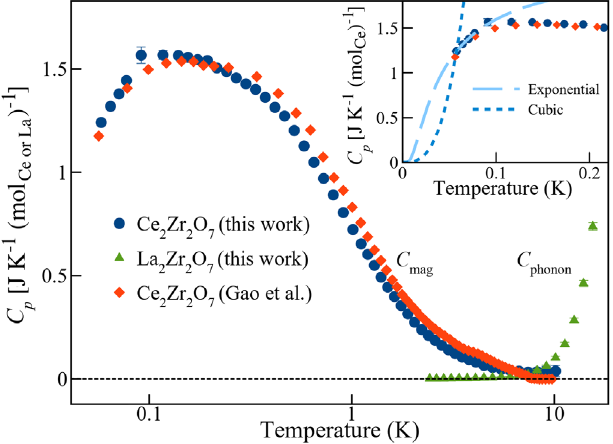
FIG. 3. The magnetic contribution to the heat capacity ( C for the Ce 2 Zr 2 O 7 single crystal measured in the present work (blue) and in previous work by Gao et al. (red) [8]. The phonon contribution to the heat capacity, estimated from measurements on a La 2 Zr 2 O 7 sample (green), was removed from C C . The inset shows the best-fit simple exponential and cubic mag extrapolations to T ¼ 0 K for the present Ce 2 Zr 2 O 7 C exponential extrapolation, with an energy gap of ∼ 0 . 035 K, can smoothly connect to the finite temperature data, while a cubic extrapolation